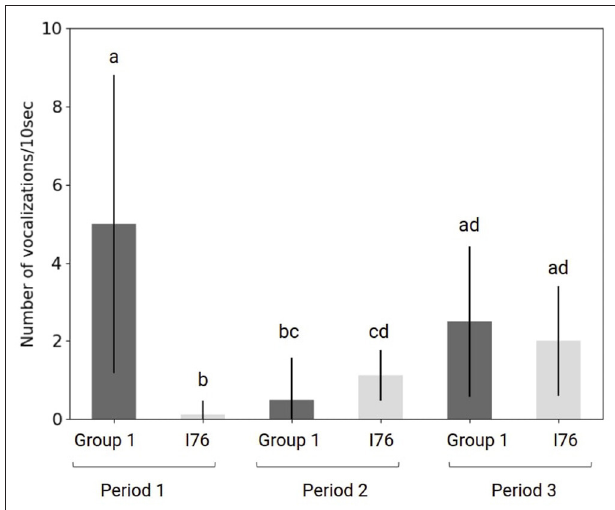
FIGURE 13 | Graph of the call rate of the 31st of August for each period and for the group (dark gray) and the male I76 (light